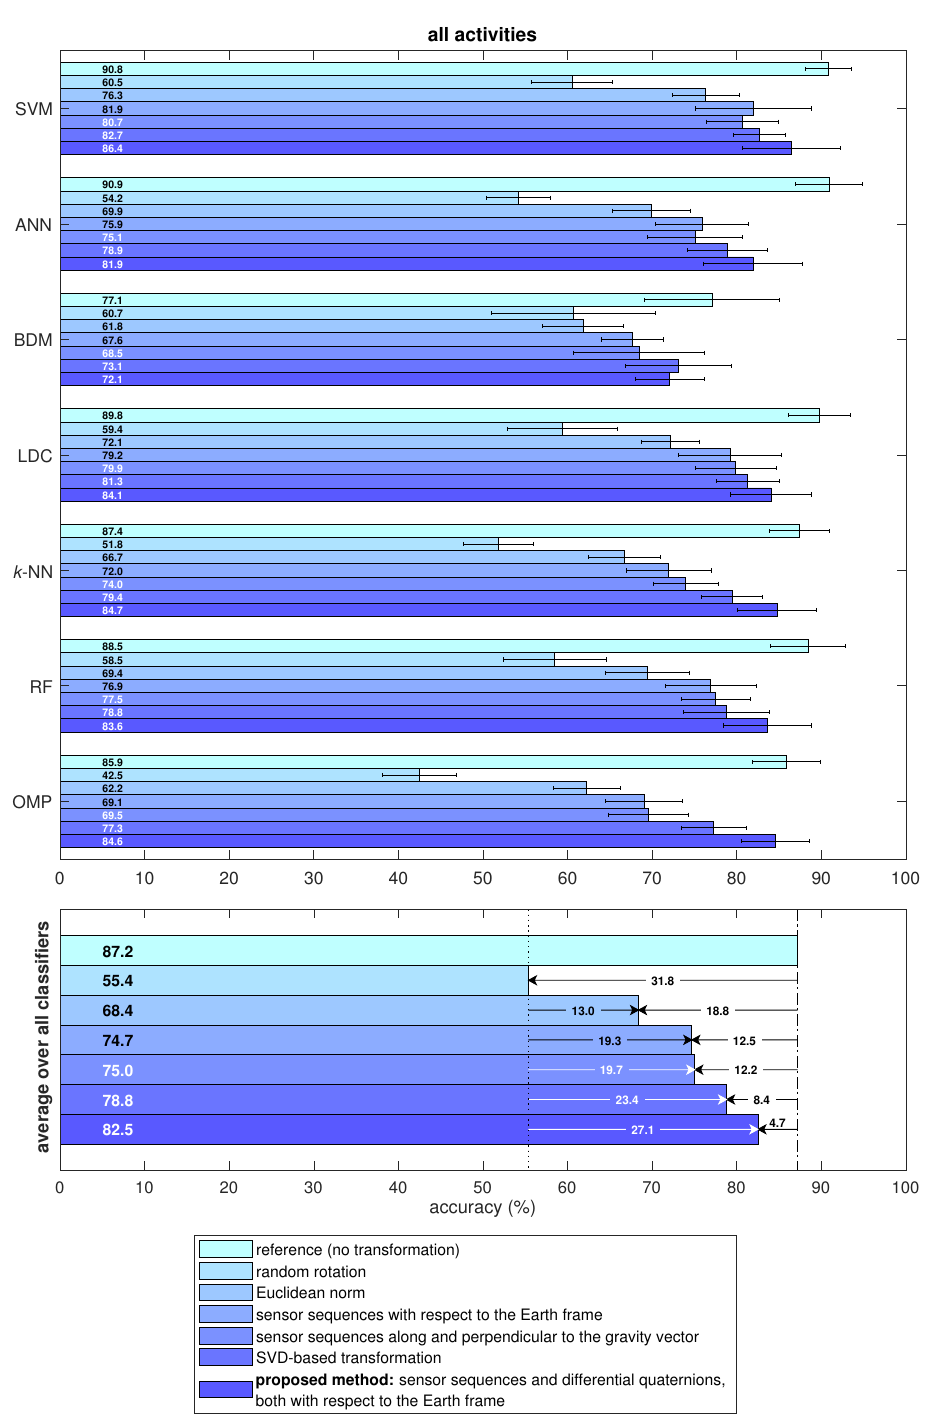
Figure 9. Activity recognition performance for all the data transformation techniques and classifiers over all activities. The lengths of the bars represent the accuracies and the thin horizontal sticks indicate plus/minus one standard deviation over the cross-validation